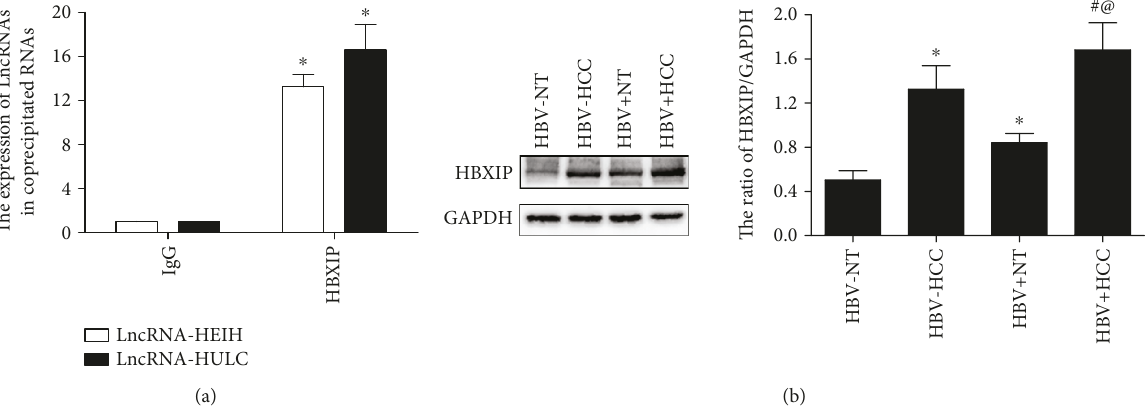
Figure 2: LncRNA-HEIH and LncRNA-HULC coimmunoprecipitates with HBXIP. (a) The expression levels of LncRNA-HEIH and LncRNA-HULC in the samples co-precipitated by HBXIP ( n = 25 per group). ∗ p < 0 05 vs. the IgG group. (b) The expression levels of HBXIP in liver tissues ( n = 25 per group). ∗ p < 0 05 vs. the HBV-NT group; # p < 0 05 vs. the HBV +NT group; p < 0 05 vs. the HBV-HCC